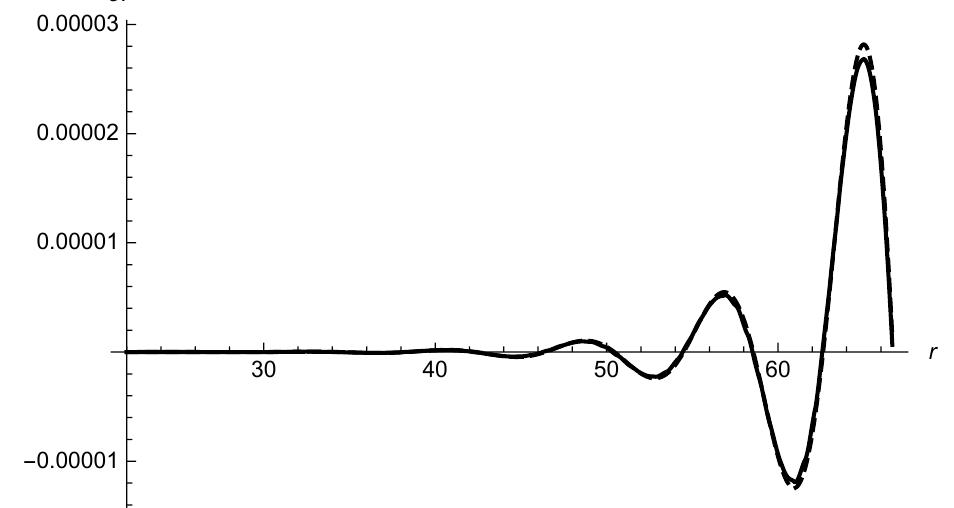
Figure 1. Comparison between the real parts of the gravitational energy of the axial perturbation. The continuous line represents the values of the numerical integration of the energy, whereas the dashed line represents the values obtained from the approximate analytic expression (34). The parameters used are A = 10 − 6 , m = 1. The frequency was required to be the fundamental frequency ( n = 0, l = 2) ω = 0.373162 − i 0.089217, obtained from the third-order WKB method. The data represent the initial instant of time of the perturbation, i.e., t =